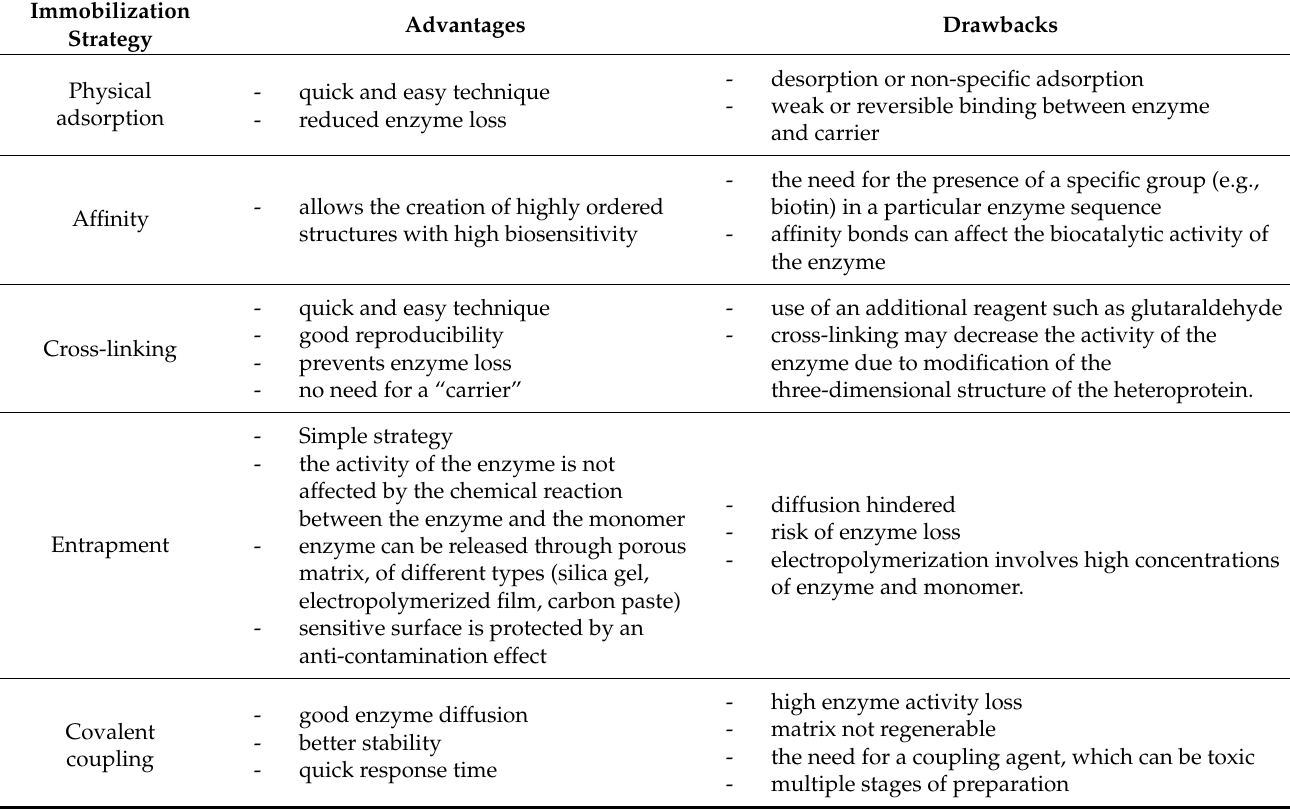
Table 1. Advantages and disadvantages of the main immobilization